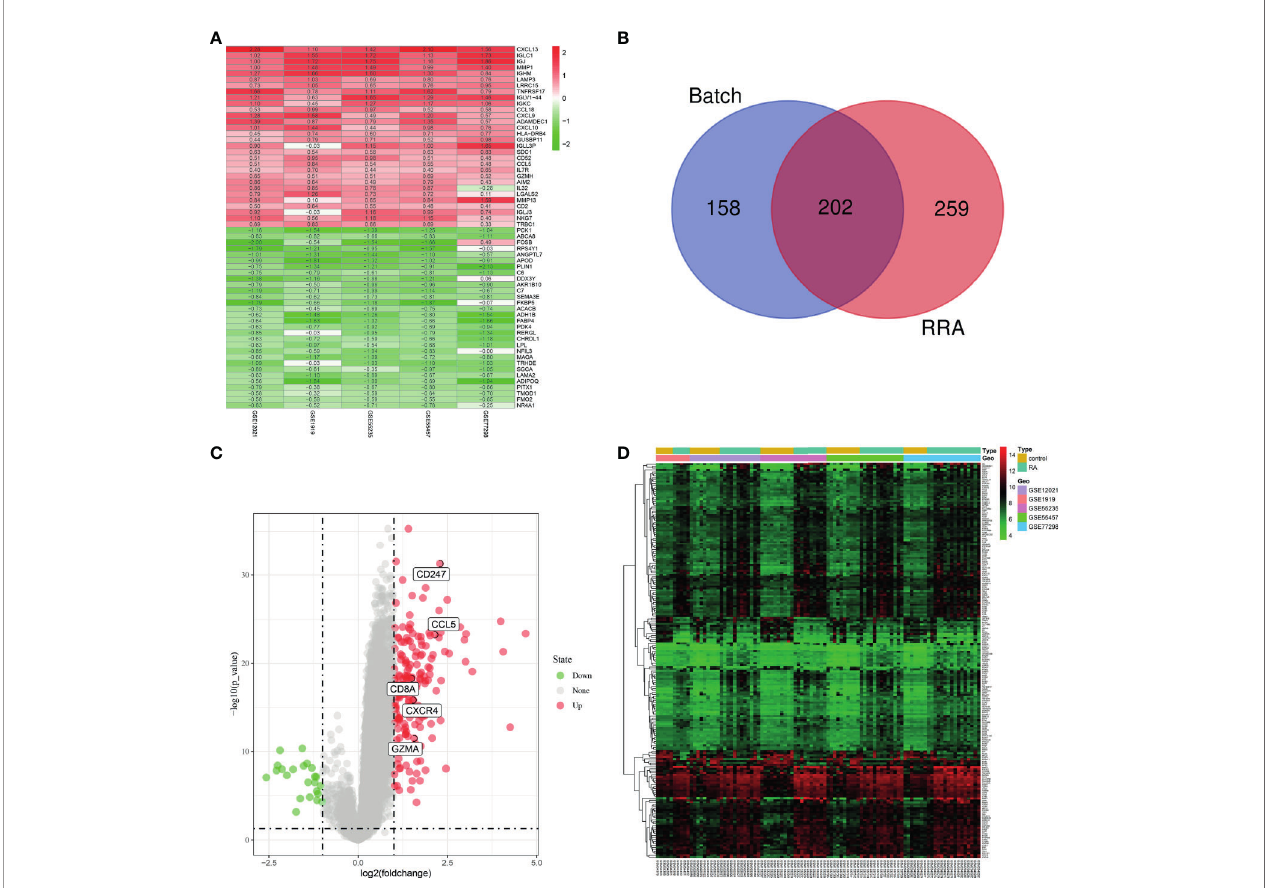
FIGURE 4 | Identi fi cation of DEGs. (A) First 30 upregulated and downregulated DEGs of the fi ve datasets determined by “ RRA ” . (B) Venn diagram was conducted to obtain the intersection of the DEGs screened by the two methods. The fi nal DEGs were visualized by the volcano map (C) and heatmap (D)